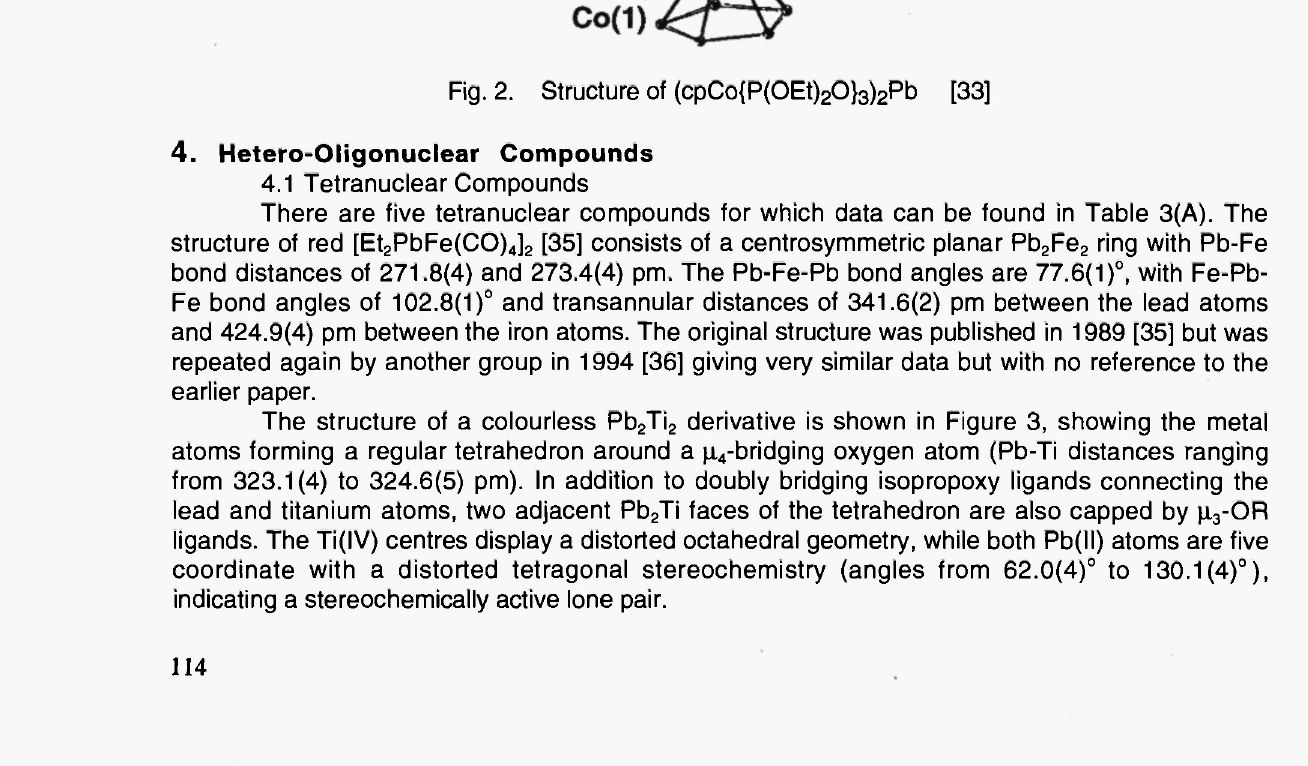
Fig. 2. Structure of (cpC0{P(0Et) 2 0} 3 ) 2 Pb